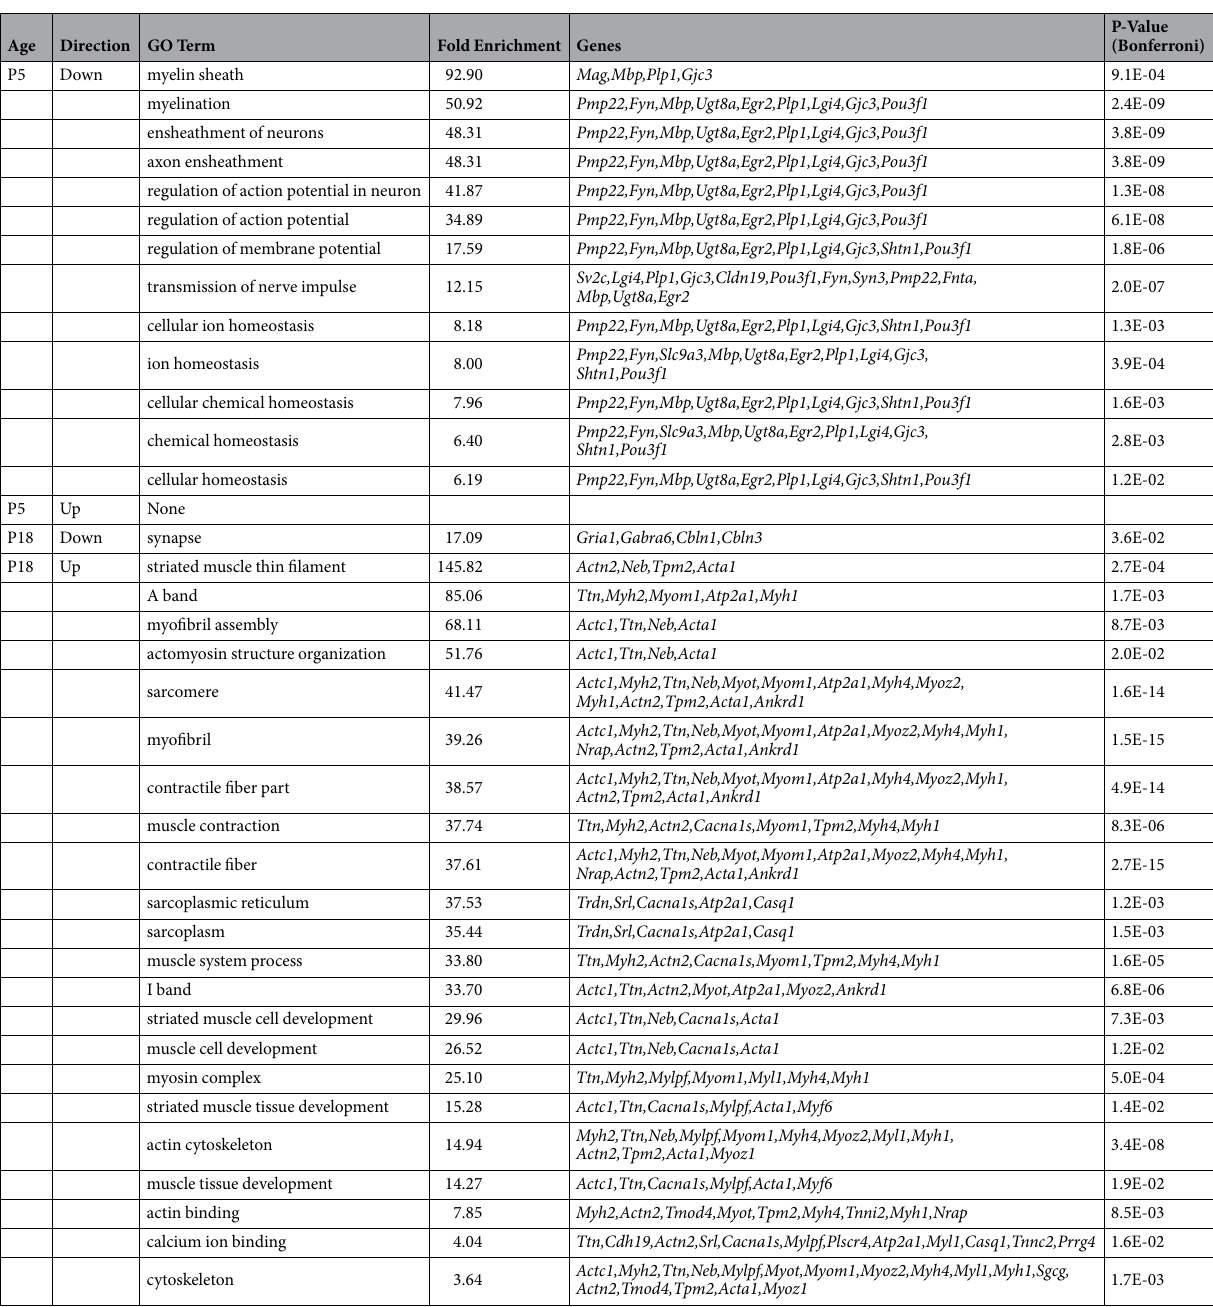
Table 4. Overrepresented Gene Ontology (G) terms for upregulated and downregulated genes in P5-OC and P18-cochlea. FDR < 0.05, fold-change ± 1.5. Gene totals (Up|Down): P5-OC (27|93); P18-cochlea